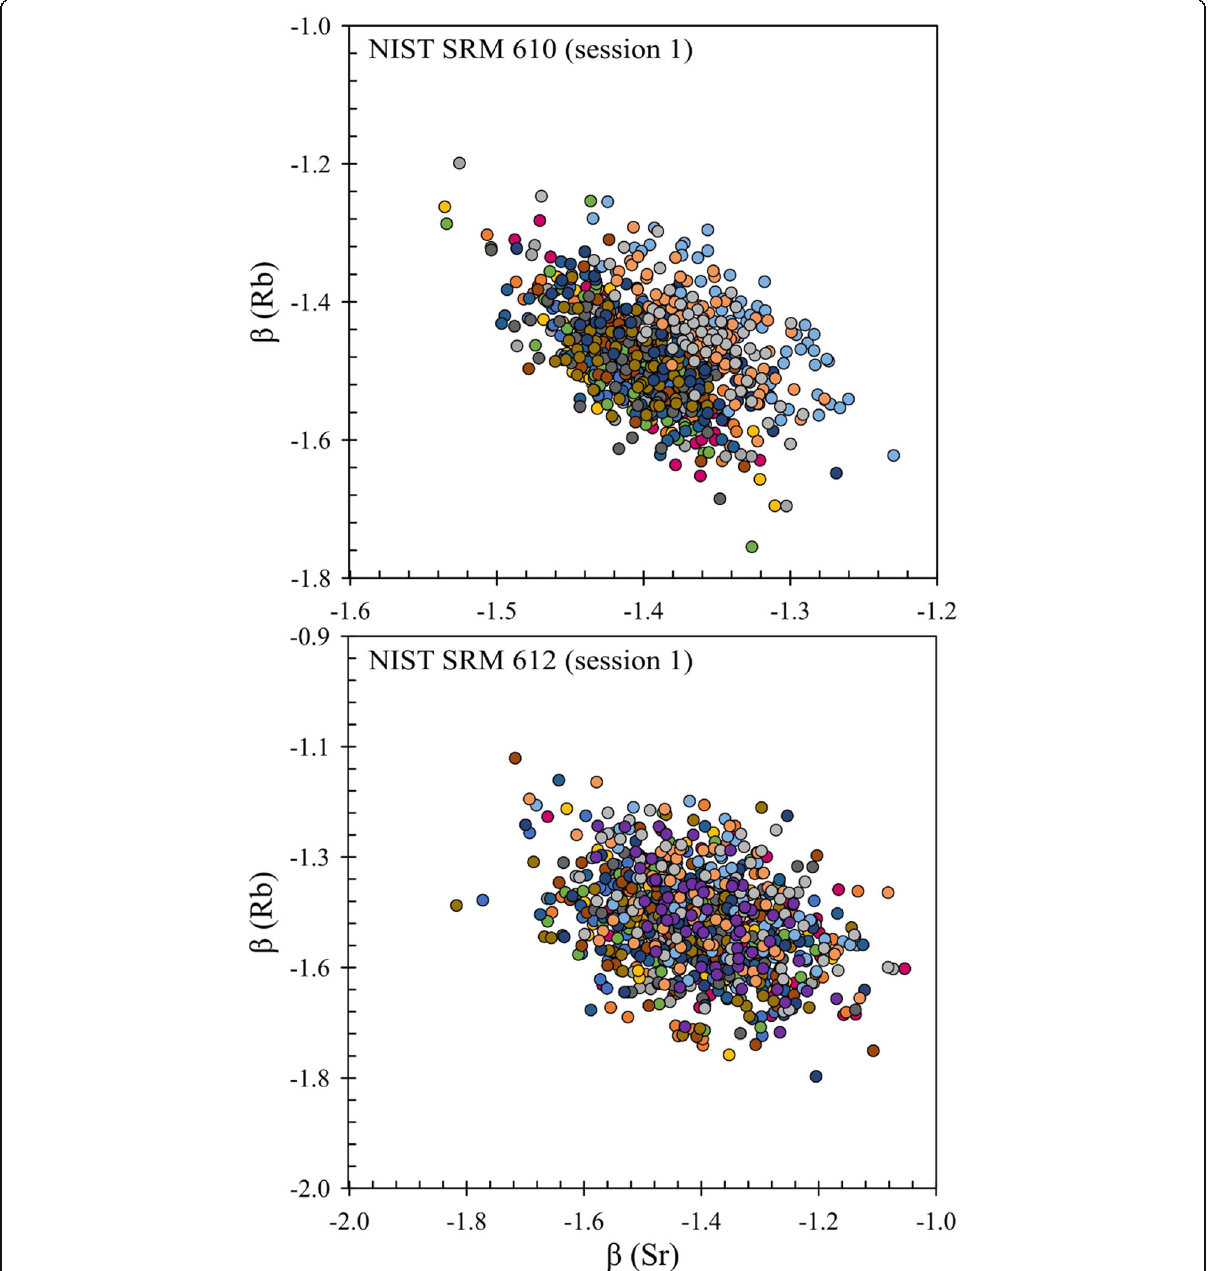
Fig. 4 Plots of β (Rb) versus β (Sr) calculated from NIST SRM data for analytical session 1 of LA-MC-ICPMS. Data for each analyzed spot are shown in different